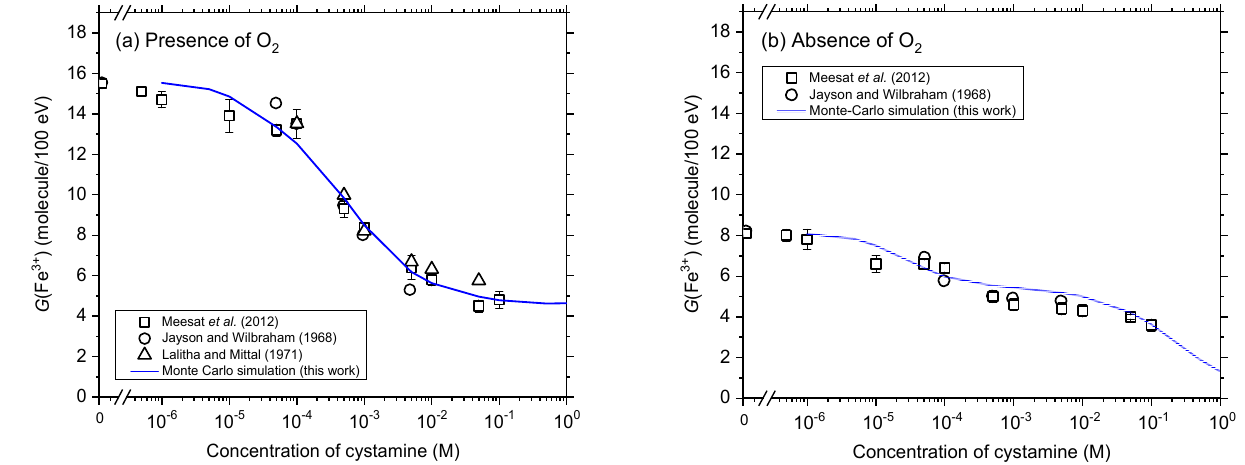
Figure 3. Dependence of the yield of Fe 3+ ions obtained from our Monte Carlo simulations of the radiolysis of Fricke-cystamine solutions (at ~200 s after ionization) upon the concentration of added cystamine in the range 10 − 6 –1 M, using 300-MeV incident protons in the absence of dose-rate effects ( N = 1) under aerated (panel ( a )) and deaerated (panel ( b )) conditions at 25 °C (solid line). Experi- ment: ( ○ ) Jayson and Wilbraham [29], ( Δ ) Lalitha and Mi tt al [30], and ( □ ) Meesat et al. [6].